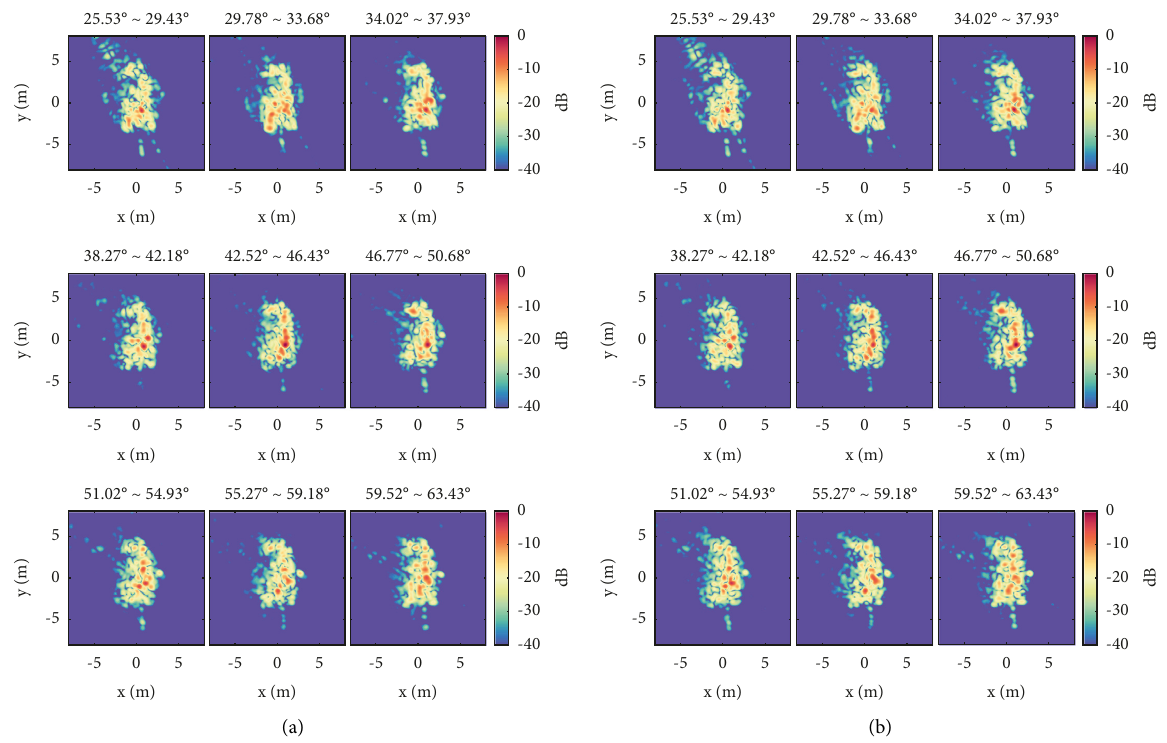
Figure 4: Changes in the (a) | S | and (b) synthetically generated | S | at 3 . 9 ° intervals over a range of 25 . 5 ° to 63 . 5 ° azimuth and 30 ° HH RL depression angle. The illumination is from the bottom at x � 0, and the target rotation is